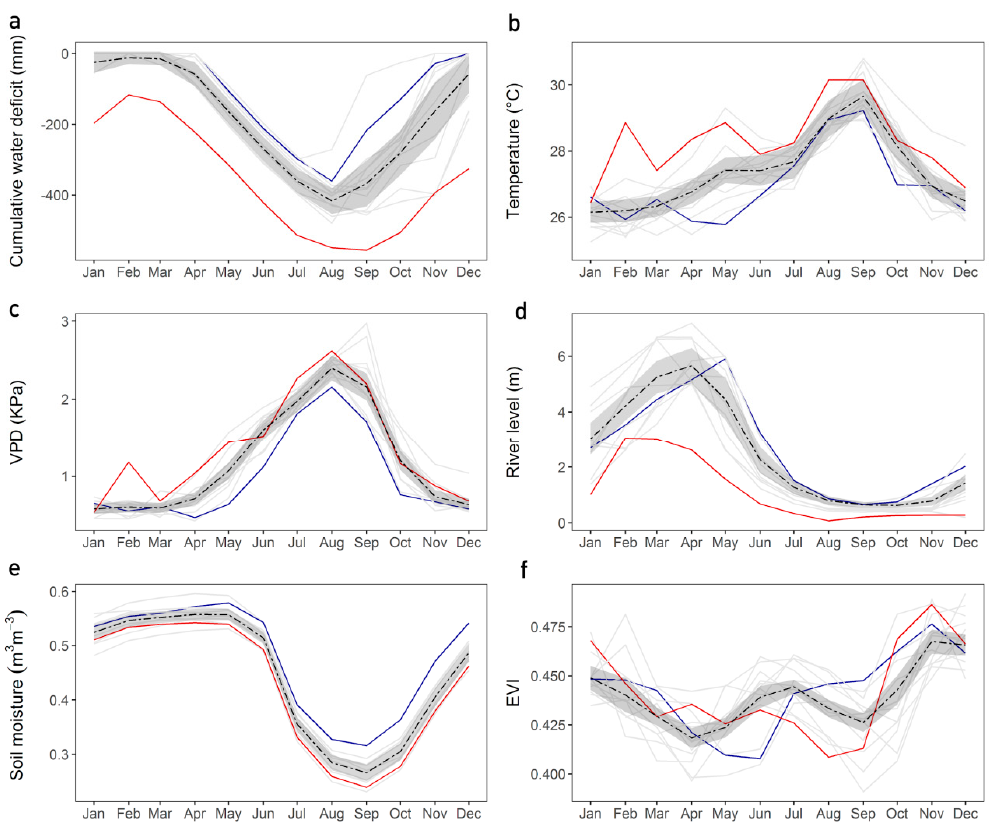
Figure 7. Monthly variation of CWD ( a ), temperature ( b ), VPD ( c ), river level ( d ), soil moisture ( e ) and EVI ( f ). The dashed line represents the average value (2004–2016), the standard deviation of the monthly variables is indicated by the grey shading, the blue line represents the wettest year (2009), the red line the driest year (2016) and grey lines represent remaining years (2004 – 2015). The period of leaf exchange in 2009 occurred from July to December, while in 2016, there were two peaks of EVI, a small peak from April to June and another from October to November. Thus, we did not observe the bimodal pattern in 2009, and in 2016 leaf renewal and photosynthetic capacity period have changed due to the decrease of flooding and increases in atmospheric demands, observed through VPD, CWD and temperature. 4. Discussion The annual average pattern of ET and GPP suggests that free water is exerting an influence on the evaporative processes during the flooded period since the peak of ET observed in March, matched the flooding peak. Our analysis confirms the free water evaporation hypothesis reported by Borma et al. [42] when observing higher values of ET during flood than during the dry season and lower GPP values [43]. This decoupled pattern of ET and GPP on the rainy-flooded period describes the forest dormancy probably due to anoxic conditions along the flooded months, as reported for Amazon flooded forests [34]. However, we observed the remaining high levels of GPP until March (one month after the flood started) and at the end of the flooded period (May), due to the shorter duration of the flooded period (or soil saturation) in higher terrain portions near the flux tower. Conversely, both ET and GPP decrease during the dry period as a result of soil moisture depletion, with the lowest values of ET occurring at the end of the dry season (September), and the